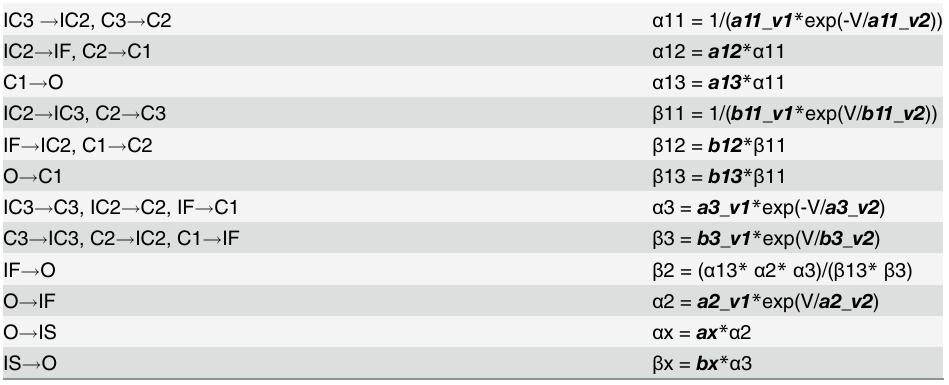
Table 1. Parameters to be optimized in the drug free Na+